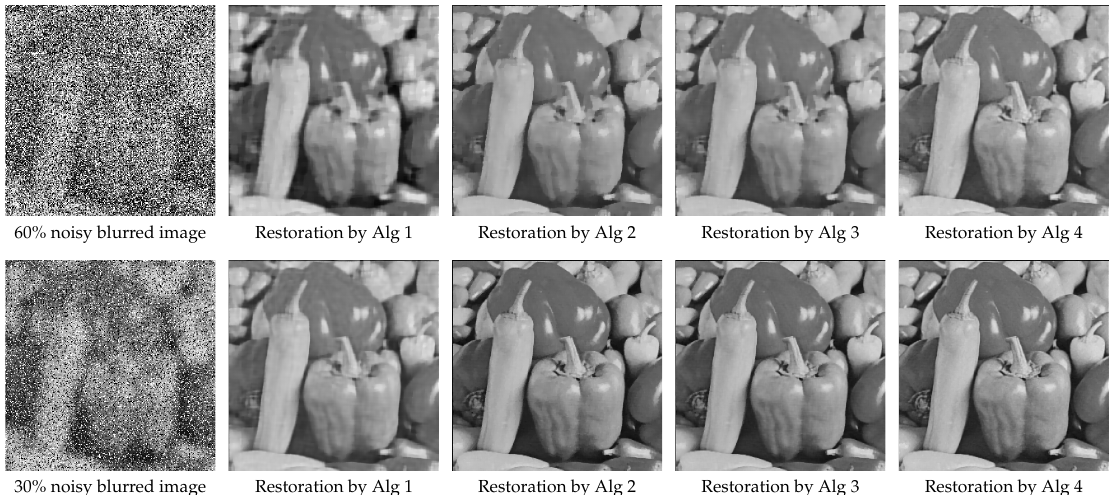
Figure 6. Image restoration for blurred Pepper image with 60% or 30% salt-and-pepper noise. Table 1. Numerical results for TVL1 problems with 20% salt-and-pepper impulse noise.